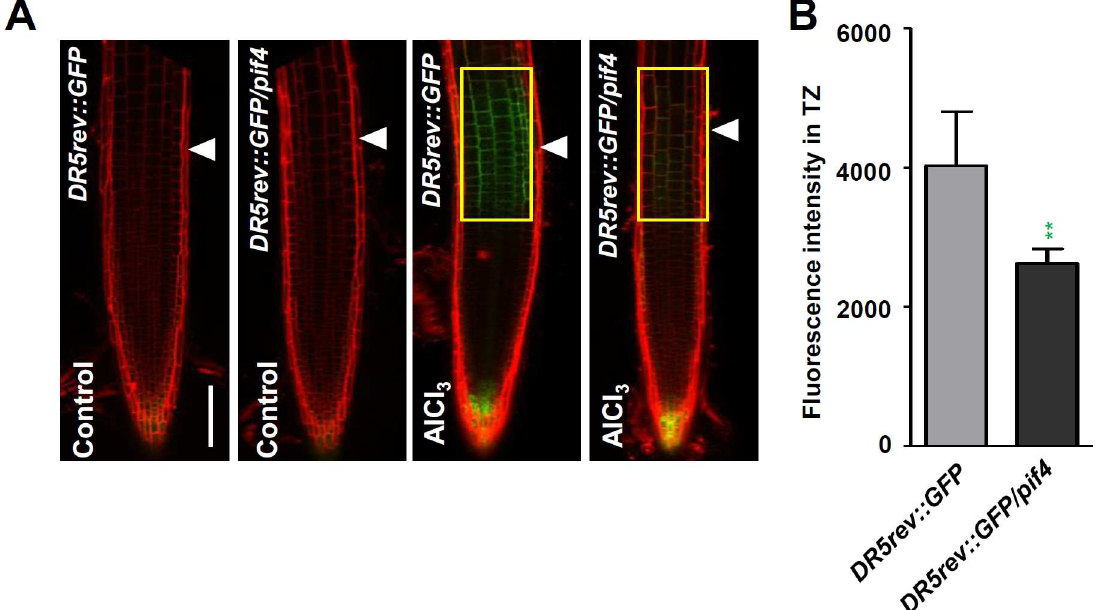
Fig 10. PIF4 regulates Al-induced local auxin signaling in root-apex TZ. (A) Five-day old DR5rev : GFP and DR5rev : GFP/ pif4-101 transgeneswere exposed or not (control) to 25 μ M AlCl 3 for 2hours. Cell boundaries appear red followingpropidium iodide staining. The root-apex TZ is marked by white arrowheads. Scale bar: 100 μ m. (B) Quantification of the Al-induced fluorescence intensity in the root-apex TZ of DR5rev : GFP and DR5rev : GFP/pif4-101 seedlings. The detected fluorescence region in TZ is marked by yellow rectangles. Cell boundaries appear red followingpropidiumiodide staining. The TZ is marked by white arrowheads. Error bars indicate mean ± SD (n (cid:21) 25). Statistical difference from detected fluorescence is indicatedby asterisks (Fisher’s exact test, ** P <